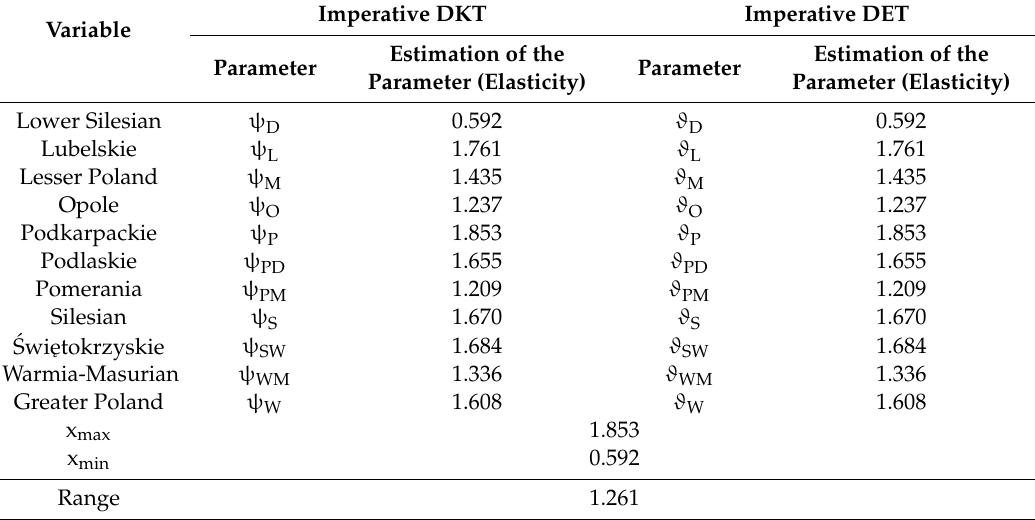
Table 4. Values of the decomposed intercepts after undoing the logarithm in imperative DLT.